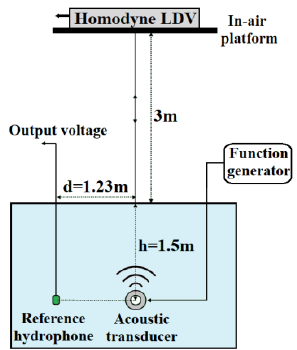
Figure 7. The setup of calibration tests of detection capability with the air–water surface under the anechoic tank.